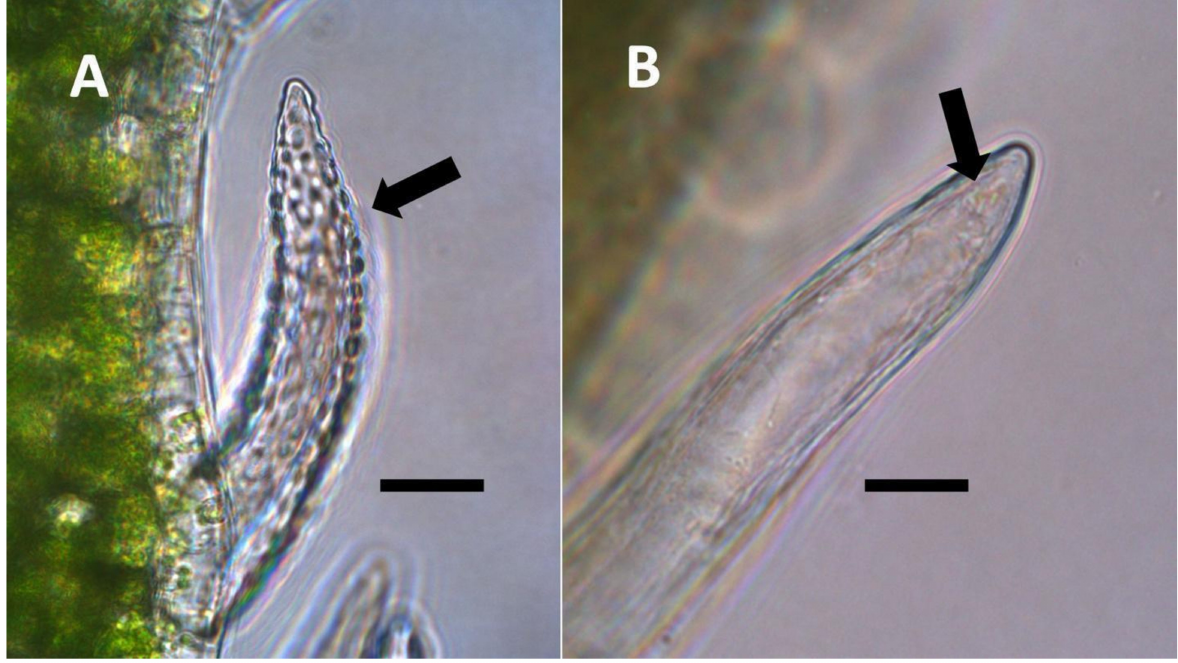
Figure 14. Trichomes of Ailanthus altissima . ( A ) Pitted filamentous trichome (arrow) grown in air, stained with acidified diphenylamine to show nitrate (blue-purple color) in hair and abundance of lateral pits (Bar = 10 µ m). ( B ) Trichome grown in air with elevated carbon dioxide, stained with acidified diphenylamine showing absence of nitrate and lateral pits; non-replicated bacterial rods (arrow) are seen in the hair tip (Bar = 10 µ